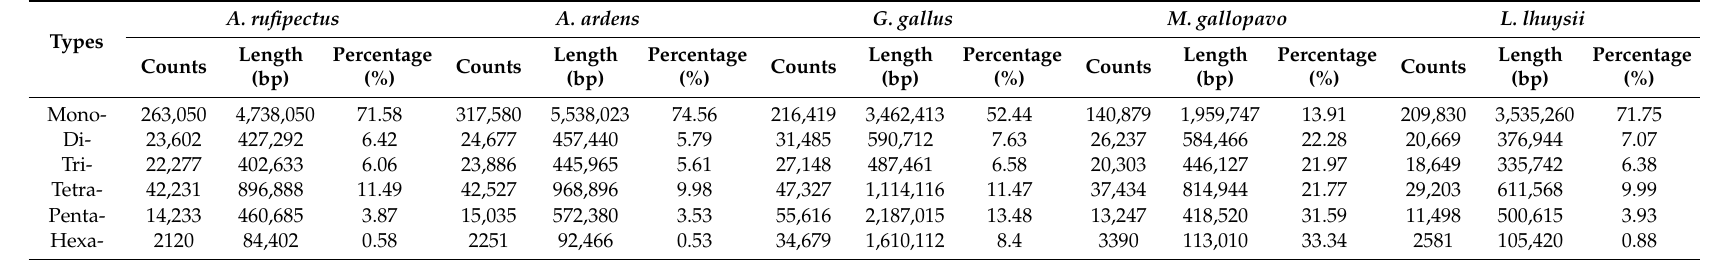
Table 3. The summary of perfect microsatellite types in five Phasianidae